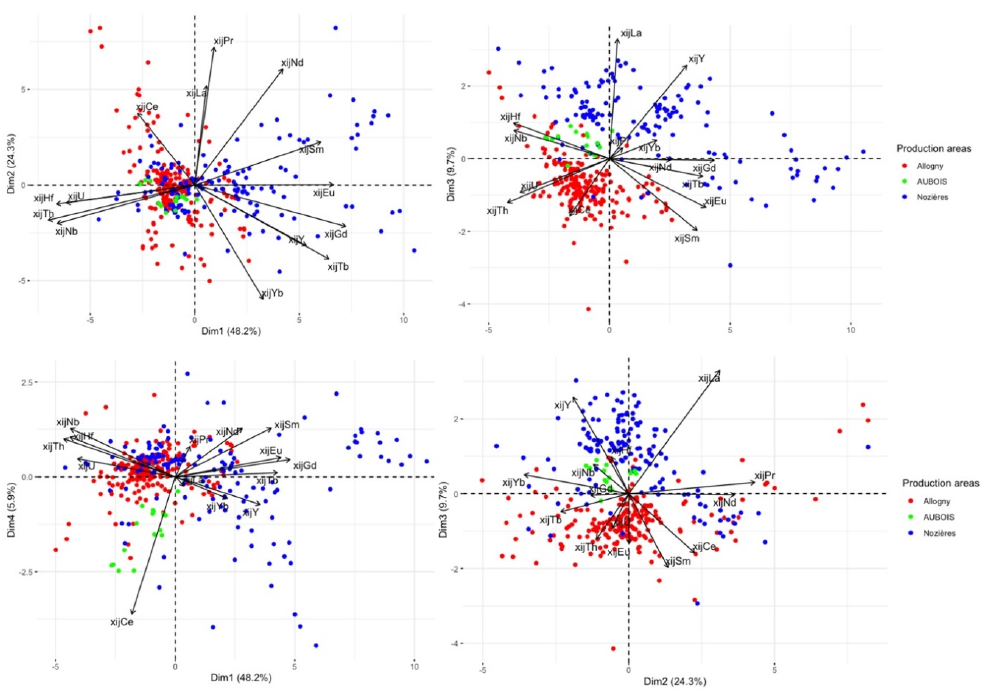
Figure 5. Principal Component Analysis (PCA) on the Xij of the production areas.